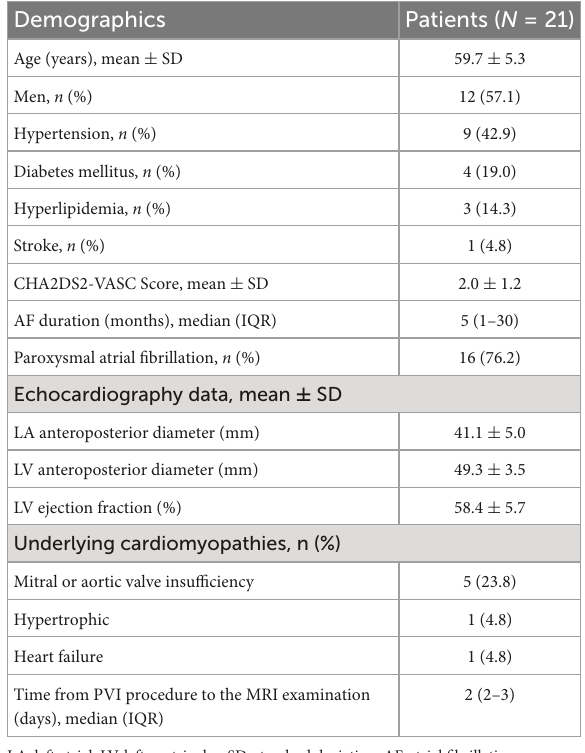
TABLE 1 Baseline characteristics of the population ( N =